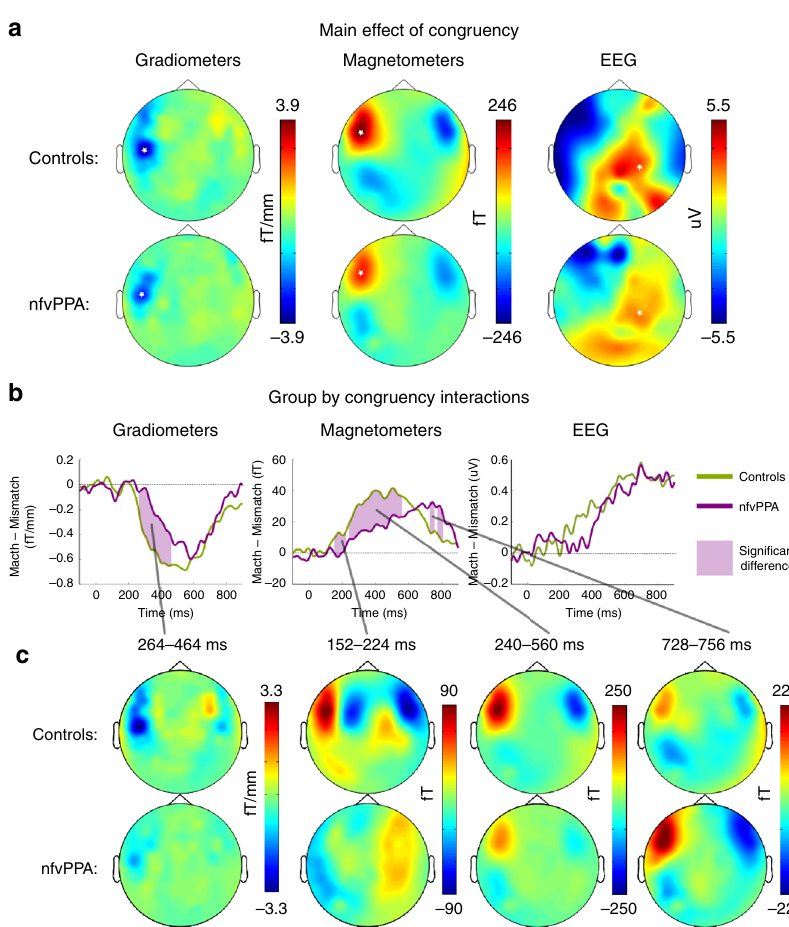
Fig. 4 The effect of prime congruency. a Illustrative scalp topographic plots of the main effect of cue congruency for each group from 400 ms to 700 ms, a period of where both groups showed a large statistical effect of congruency with similar topography. White stars indicate the scalp location of the peak congruency effect across both groups between − 100 ms and 900 ms (FWE p < 0.001 for all sensor types). b Signi fi cant group by congruency interactions ( p < 0.05 sustained for more than 25 ms at the scalp locations marked by white stars in the upper panel) were observed in planar gradiometers and magnetometers, and are shaded in lilac. c Topographic plots for each group are shown averaged across each signi fi cant cluster of group by congruency interaction